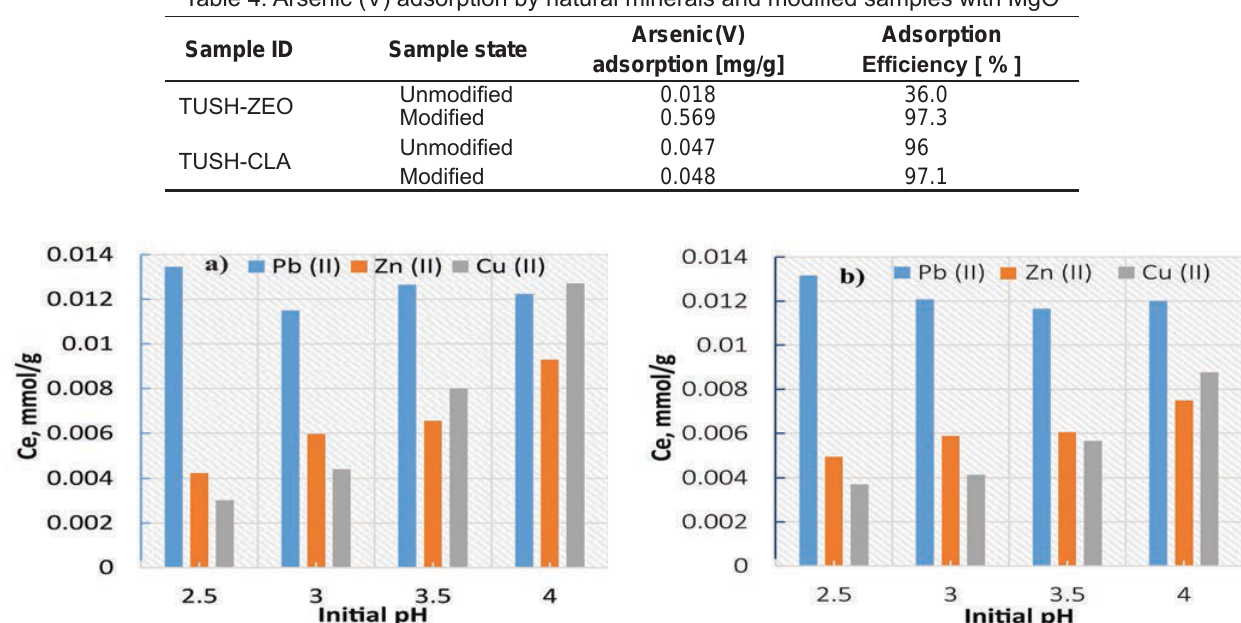
Fig. 5. Effect of pH on the adsorption of heavy metals with (a) TS.TS-ZEO and (b) TUSH-ZEO